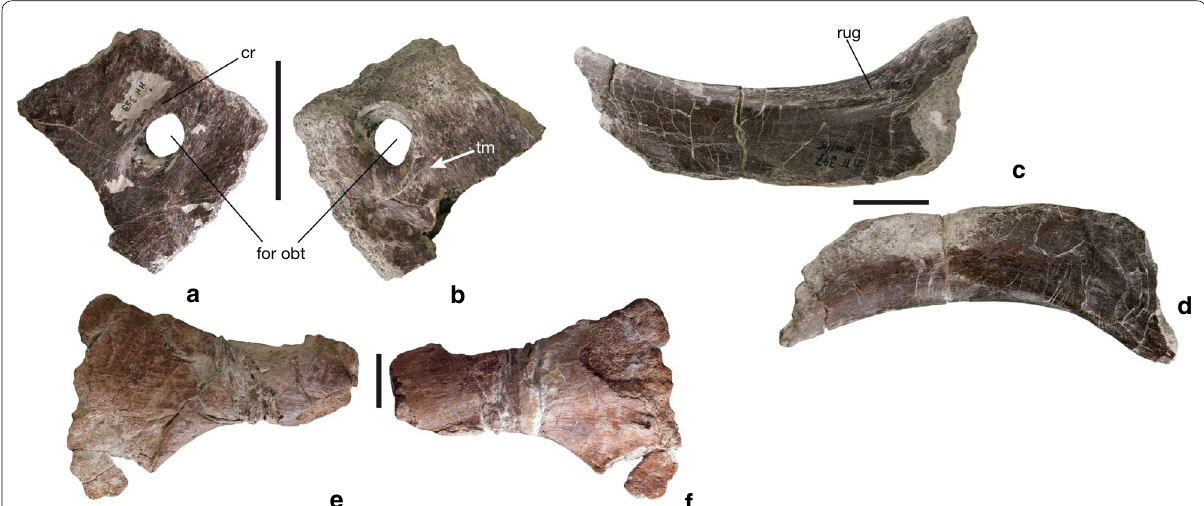
Fig. 11 Pelvic girdle of A. greppini . Left pubis NMB. M.H. 359 in a lateral and b medial aspect, white arrow shows tooth mark. Left pubis NMB M.H. 347 c in lateral and d medial aspect. Photograph of proximal part of left ischium NMB M.H. 358, e in lateral and f in medial aspect. Scale bar is 50 mm. Drawings by Serafin Padzera. cr crest, for obt obturator foramen, rug rugosity, tm tooth